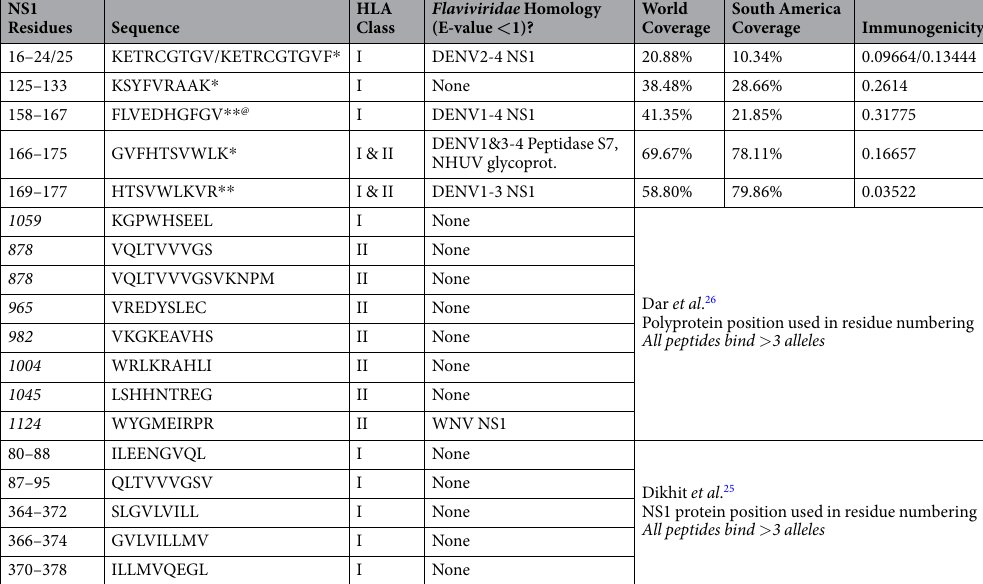
Table 1. Predicted ZIKV NS1 epitopes from consensus ZIKV NS1 sequence, Dar et al ., and Dikhit et al . * Exact MHC-NP Matches. ** Near MHC-NP Matches. @ Due to high immunogenicity and DENV1-4 homology, this peptide may serve as a positive control for DENV/ZIKV infection. Immunogenicity > 0 is the threshold for predicted